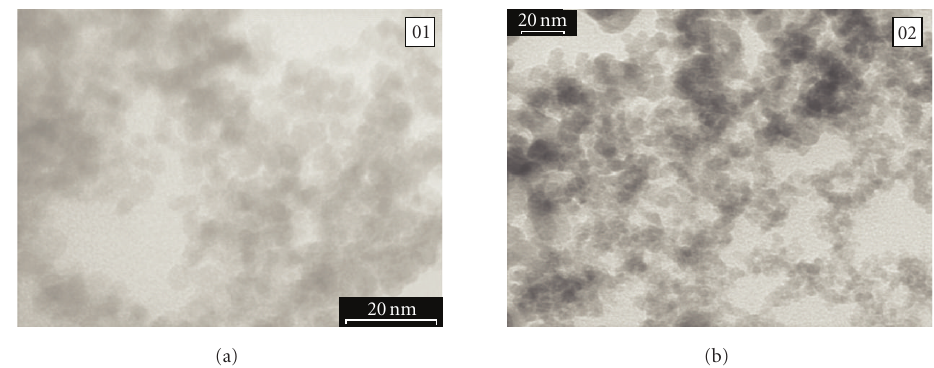
Figure 3: TEM analysis for iron oxides obtained from (a) sample 01 and (b) sample 02.